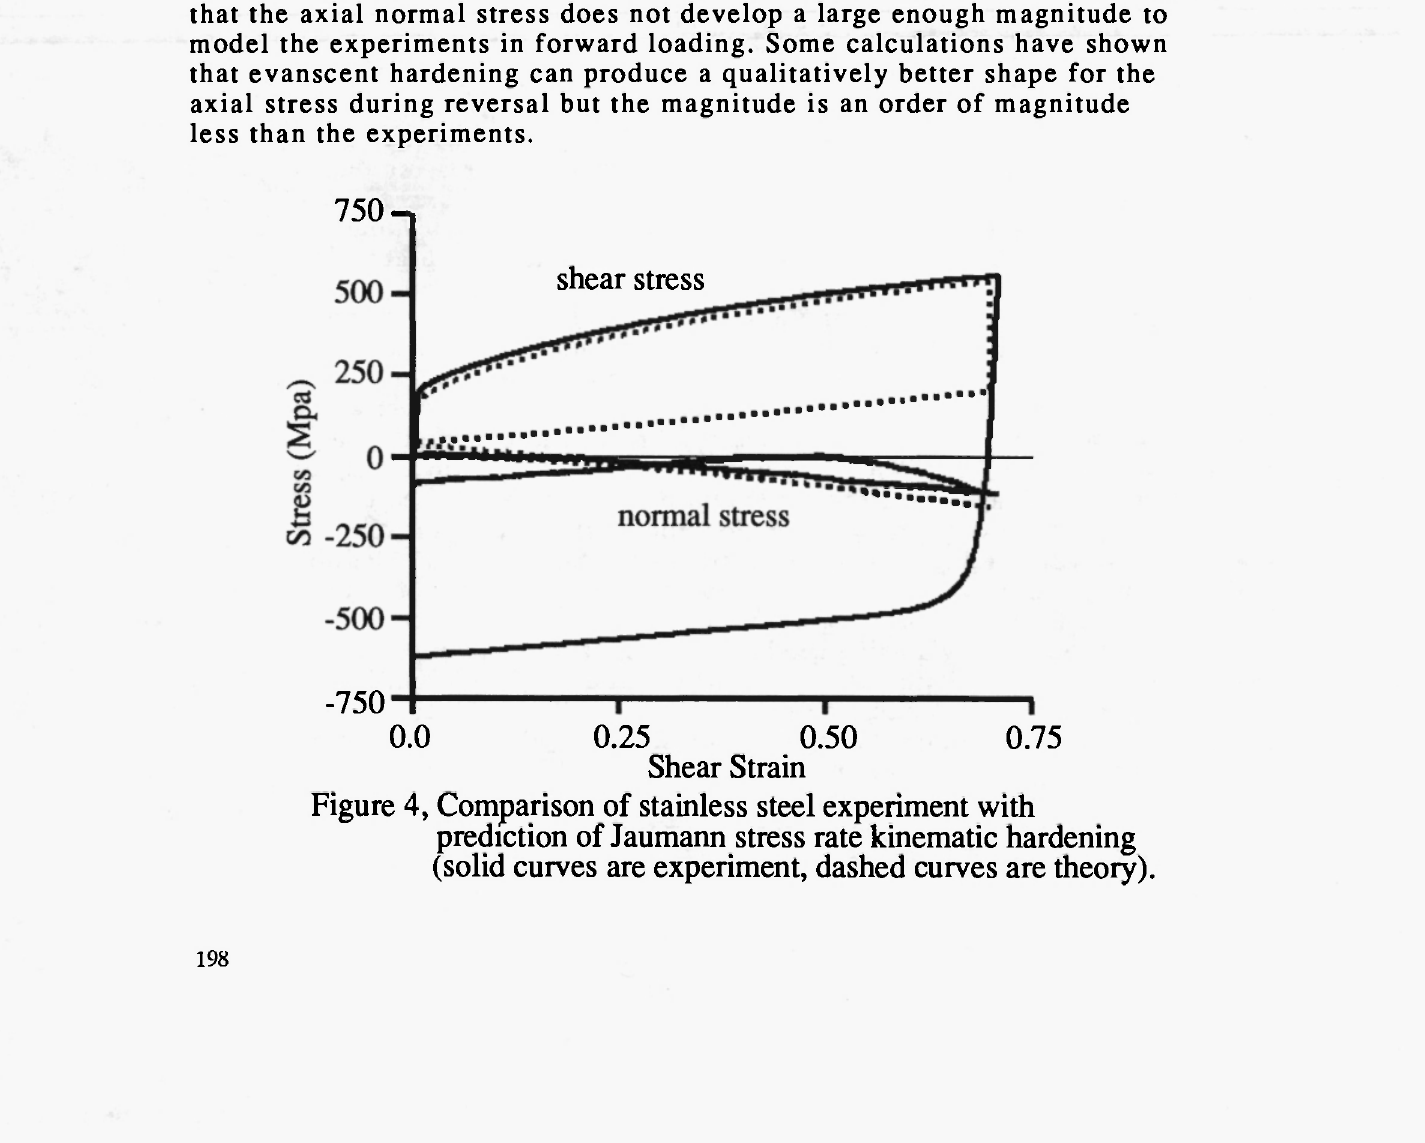
Figure 4, Comparison of stainless steel experiment with prediction of Jaumann stress rate kinematic hardening (solid curves are experiment, dashed curves are